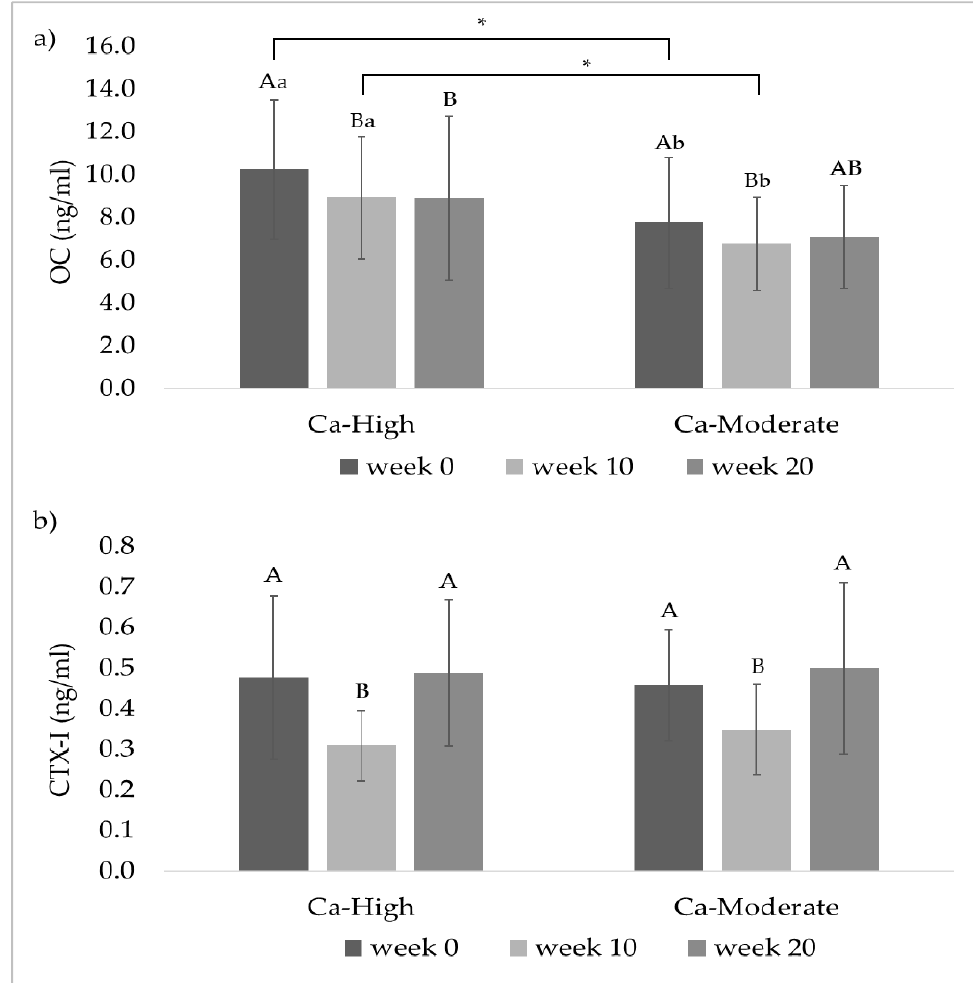
Figure 3. Concentrations of bone markers in the blood samples of the stallions (mean ± SD, given in ng/mL). ( a ) Osteocalcin (OC); ( b ) C-terminal Telopeptide (CTX-I). A, B, C Different capital letters indicate significance between the different measurement time points within a group. Means with common superscripts are not significantly different. a, b Different lower case letters indicate significant differences between the groups. Means with common superscripts are not significantly different. Asterisks indicate the level of significance. * p < 0.05.